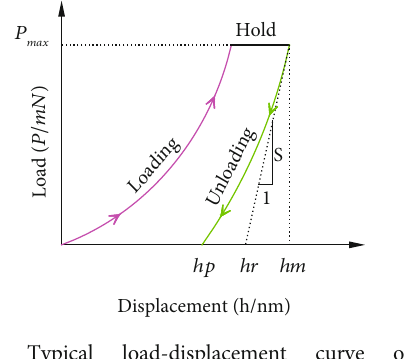
1: Typical load-displacement curve of single